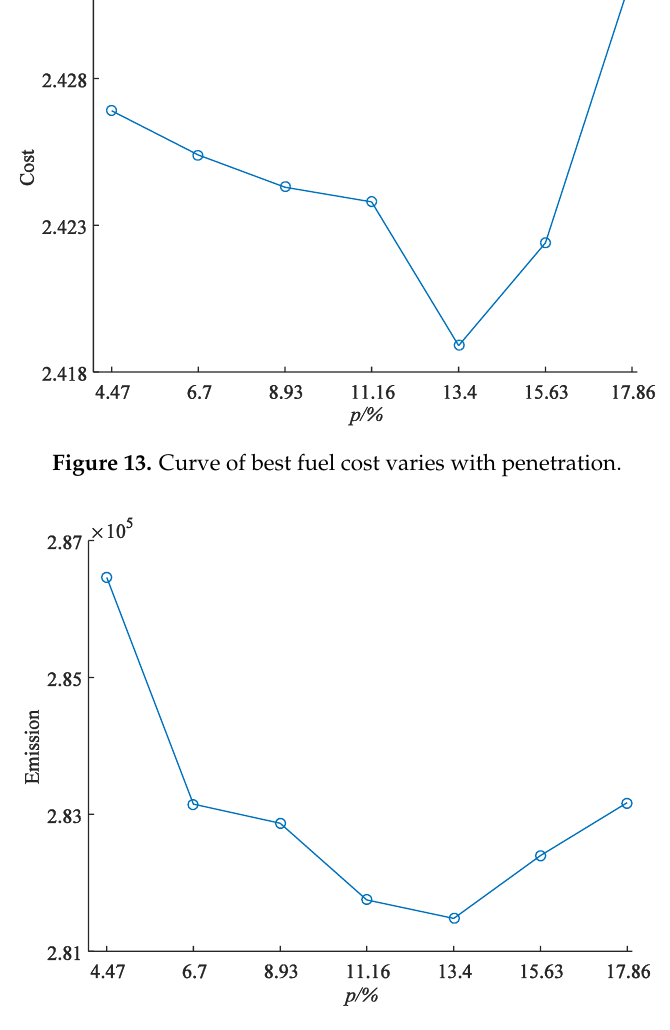
Figure 14. Curve of best pollution emission varies with penetration.